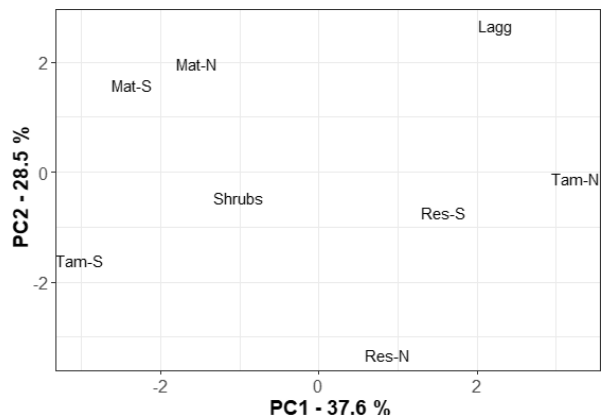
Figure B1. Principal component analysis of the 14 variables listed in Table A2.